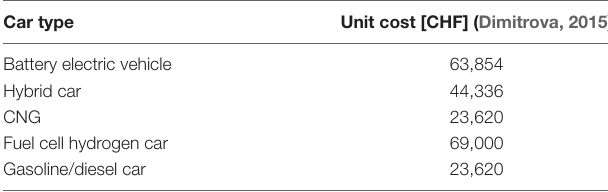
TaBle 9 | Unit cost for the passenger private vehicles.